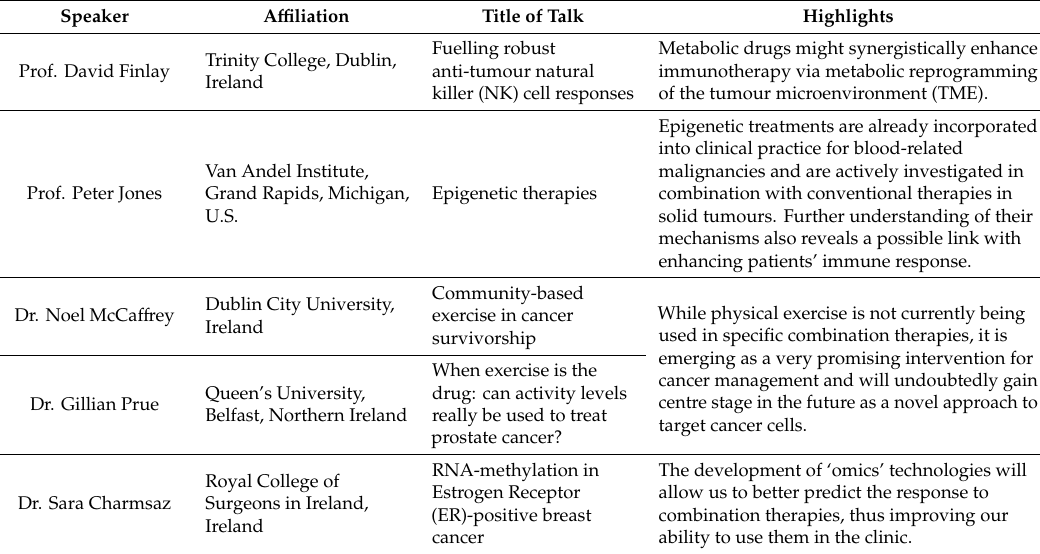
Table 1. Contributing speakers and highlights of their